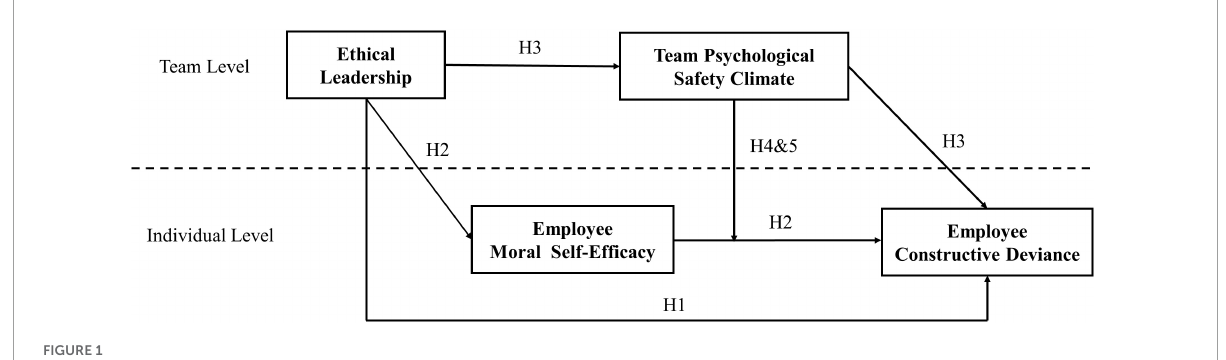
FIGURE1 Theoretical